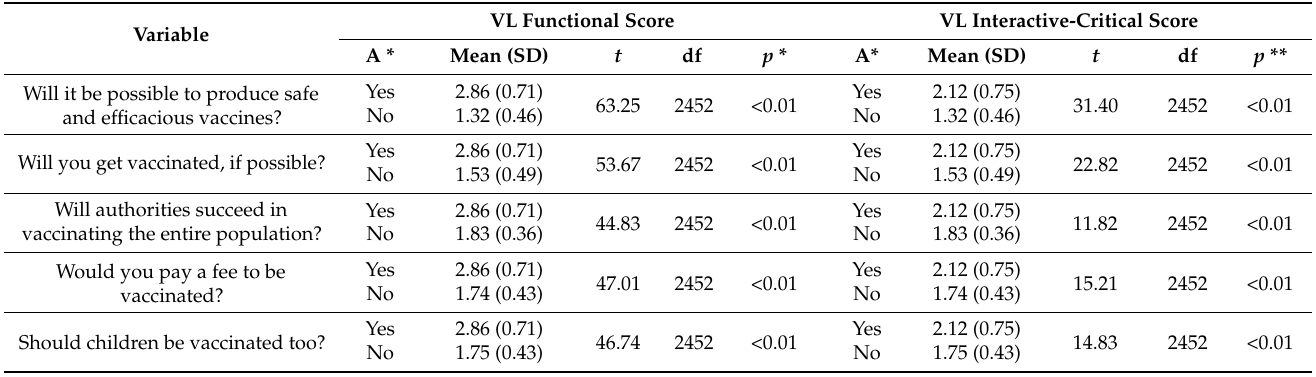
Table 4. Attitudes and perceptions about future COVID-19 vaccines and